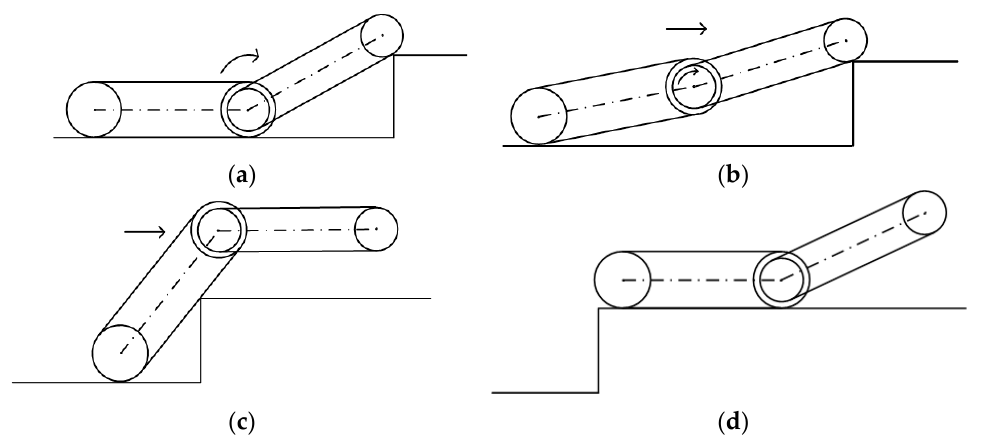
Figure 3. The process of the robot climbing the steps forward: ( a ) lift the rocker arm; ( b ) lift the body with the support of the rocker arm; ( c ) the center of mass crosses the step boundary; ( d ) the body crosses the step.